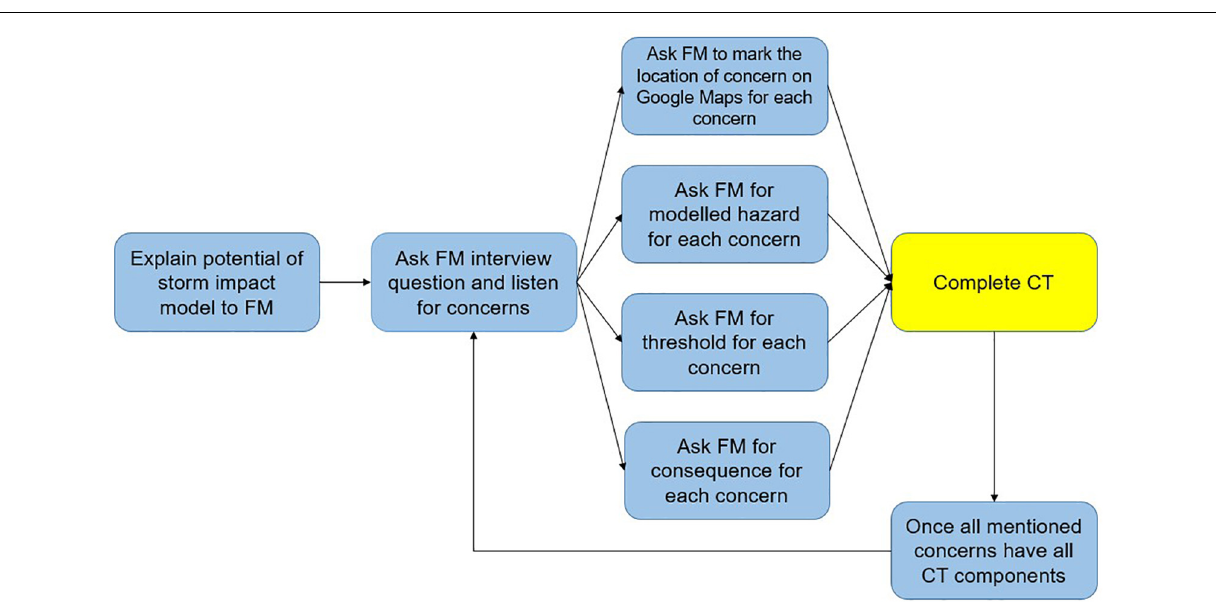
constrained (Merriam, 1988), since interviews were focused on subjects that matched the interviewee’s knowledge and points that the interviewee brought up (Lewis and Sheppard,